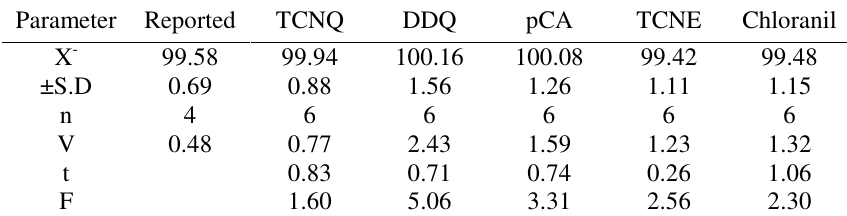
Table 5. Statistical analysis of the results obtained for assay of authentic pregabalin (PRE) drug using the proposed methods compared with the reported HPLC method